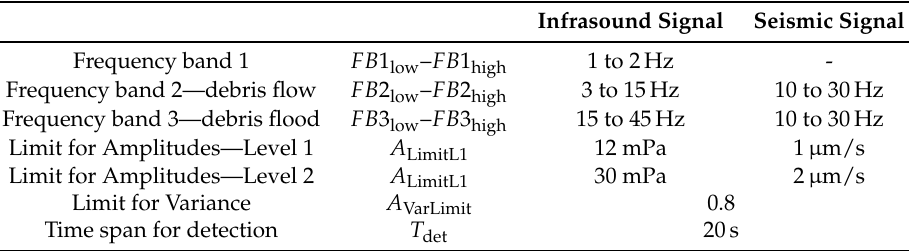
Table 2. Current settings for the detection